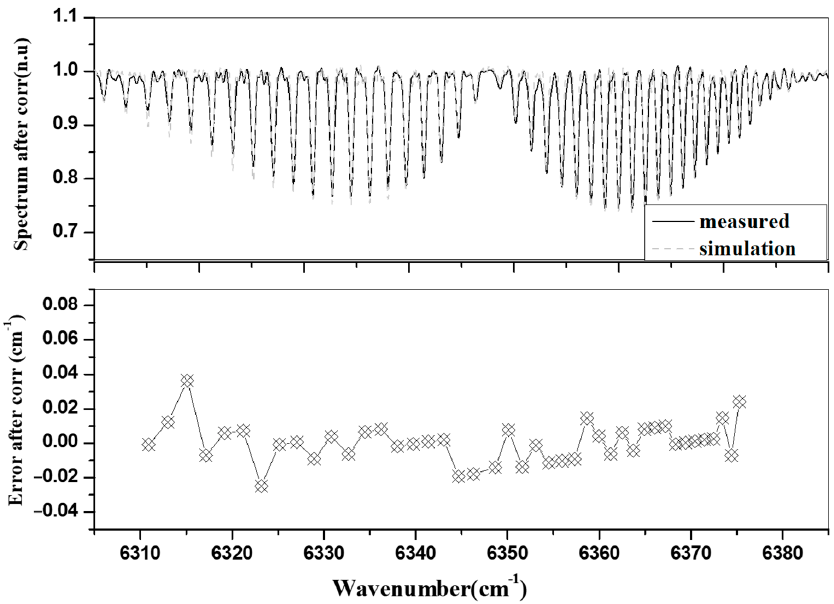
Figure 22. Experimental results after fine spectral registration.